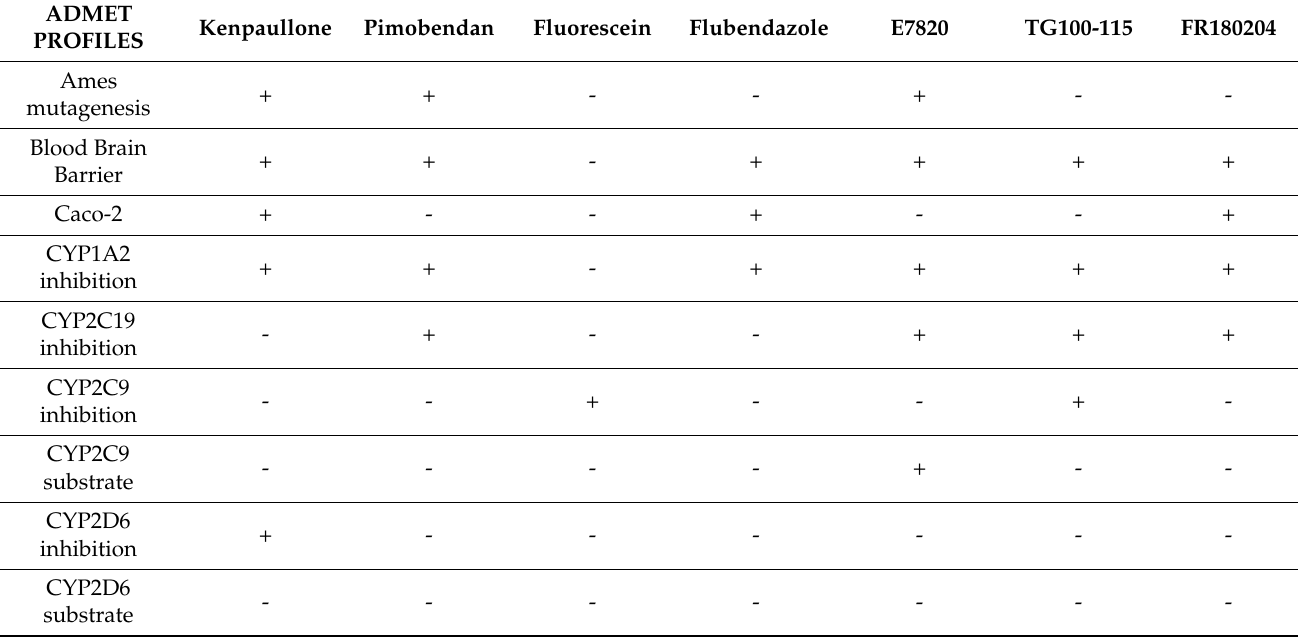
Table 3. In-silico ADMET profiling of hit compounds using ADMETSar online